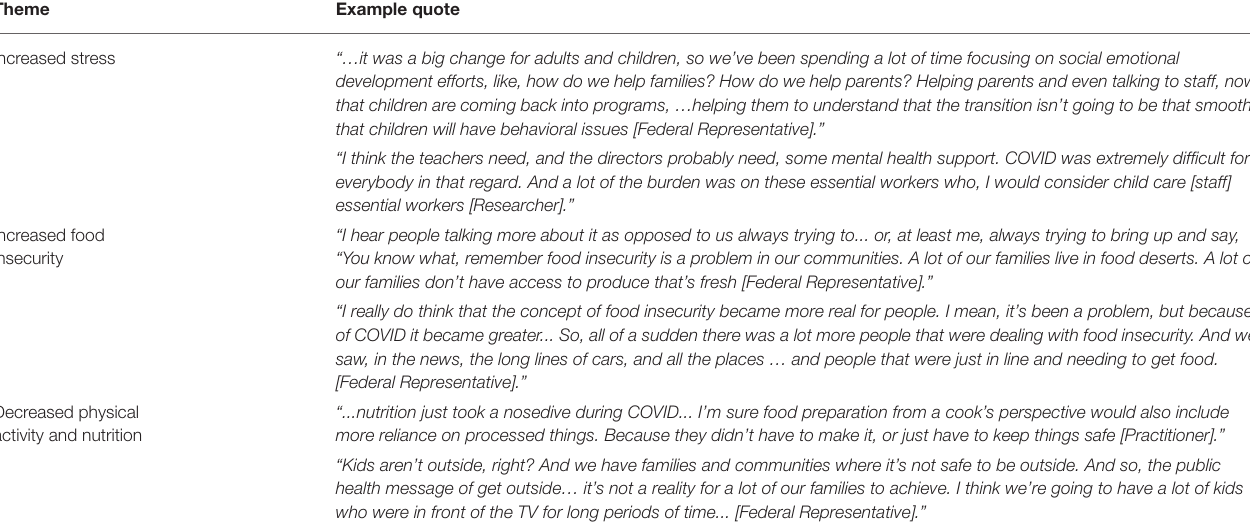
TABLE 2 | Key informant themes and quote snapshot: impacts of COVID-19 on child care settings.